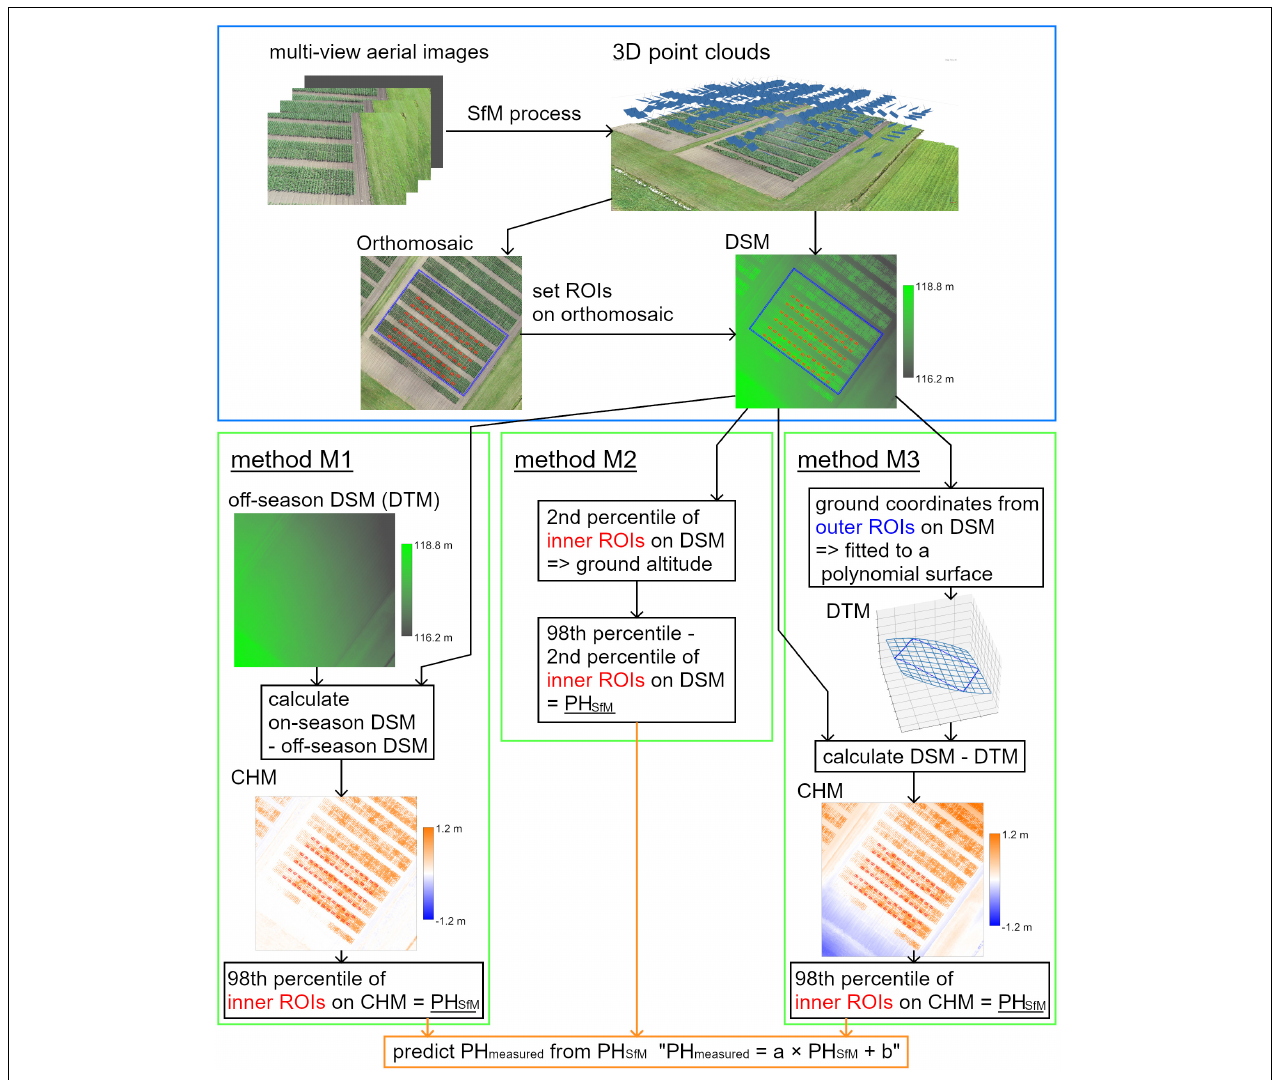
FIGURE 1 | An overview of the SfM process and three methods for obtaining ground altitude (GA); methods M1, M2, and M3. A DSM is a digital surface model that represents elevation on the 3D model, a DTM is a digital terrain model that represents elevation without plants, and a CHM is a crop height model that represents plant height of